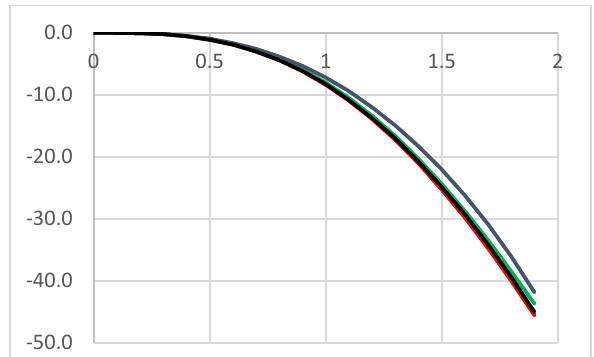
Figure 5. Radial distortion profile of camera GB camera 1st repeat (RGB – black, R – red, B – blue, G –green bands) for the individual adjustment. X axis in mm, y axis in  m.